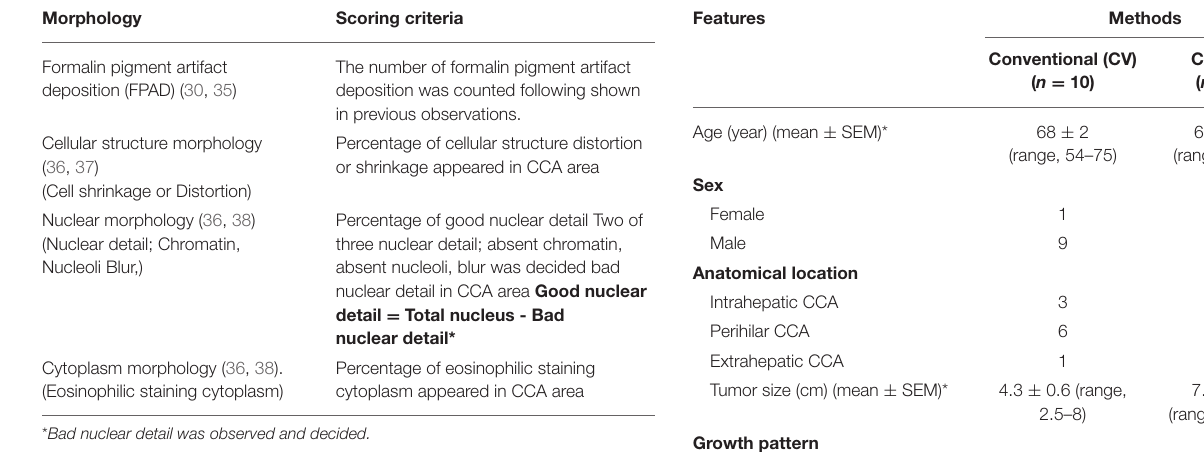
TABLE 2 | Baseline clinicopathological characteristics of the cohort.